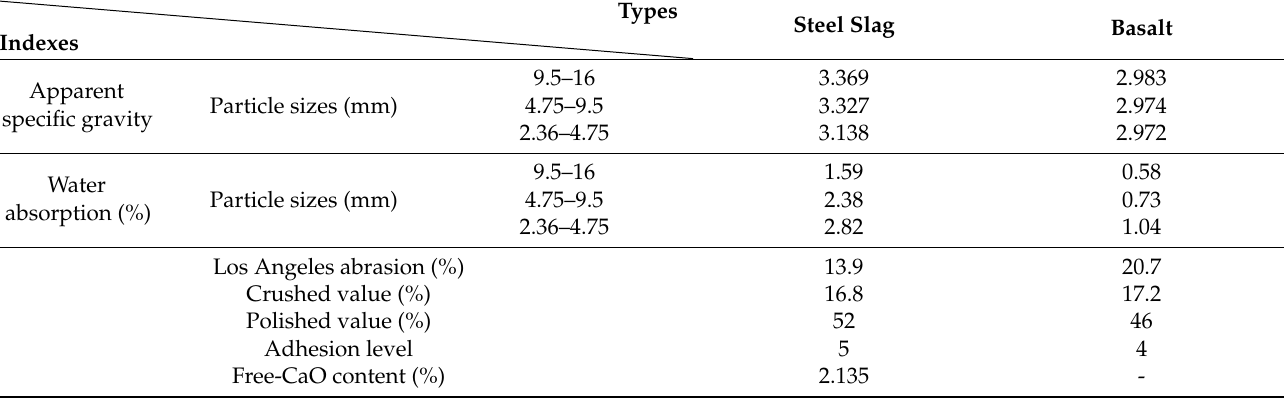
Table 1. The properties indexes of steel slag and basalt.